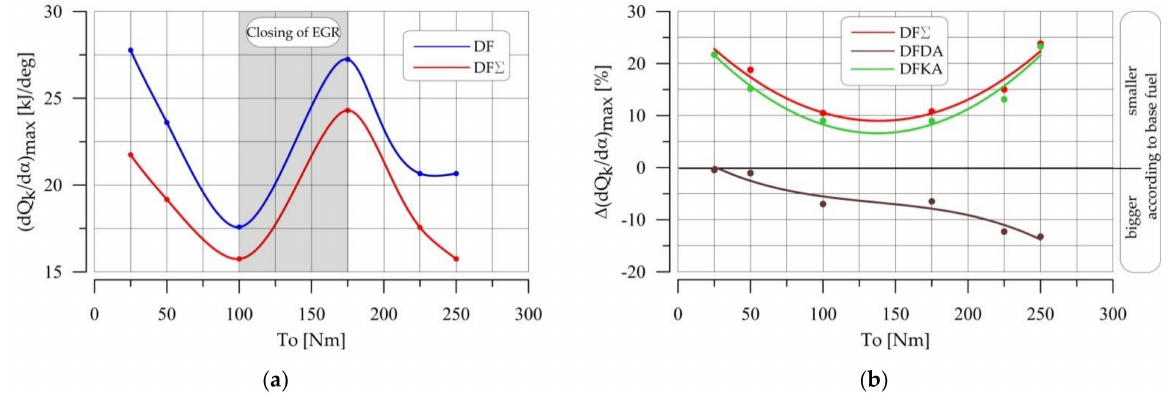
Figure 23. ( a ) Maximum kinetic combustion rate vs. engine torque; ( b ) Difference of the maximum kinetic combustion rate vs. engine torque in relation to the base